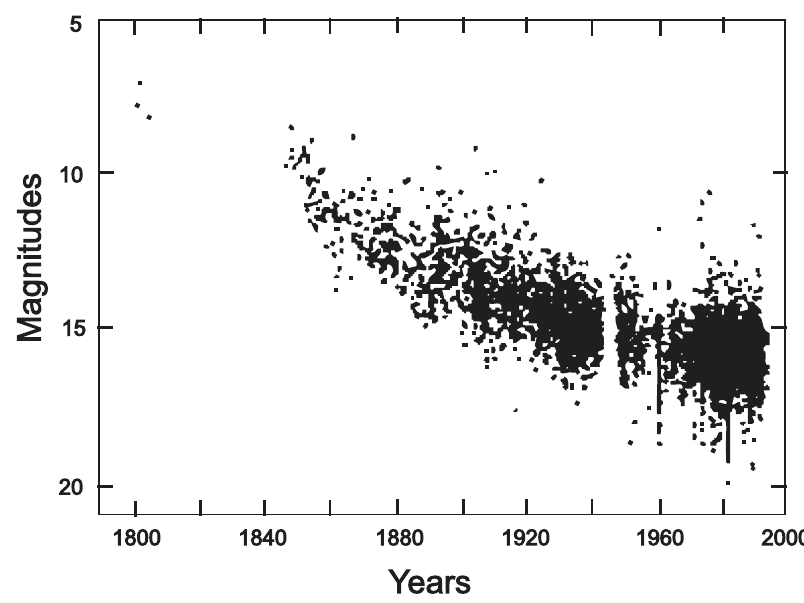
Fig. 3. The distribution of numbered minor planets over the years of their registration and magnitudes (Marsden 1994). of recurrent observations held back calculations of their